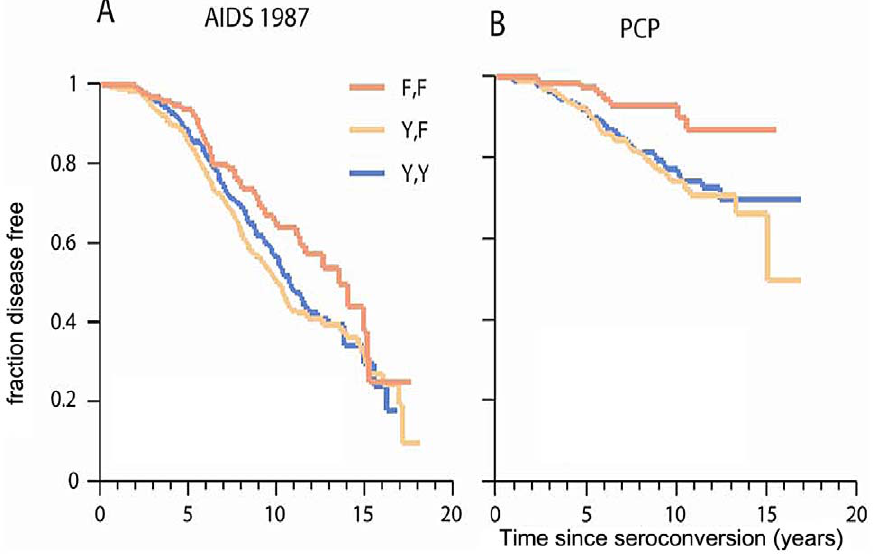
Figure 3. Genetic effect of CCRL2- 167F on AIDS progression and PCP. Kaplan-Meier survival curves of time progression since HIV-1 infection to AIDS (1987 CDC definition) (A) or to PCP (B) were plotted for CCRL2- Y167F genotypes. Circles on the curves indicate those